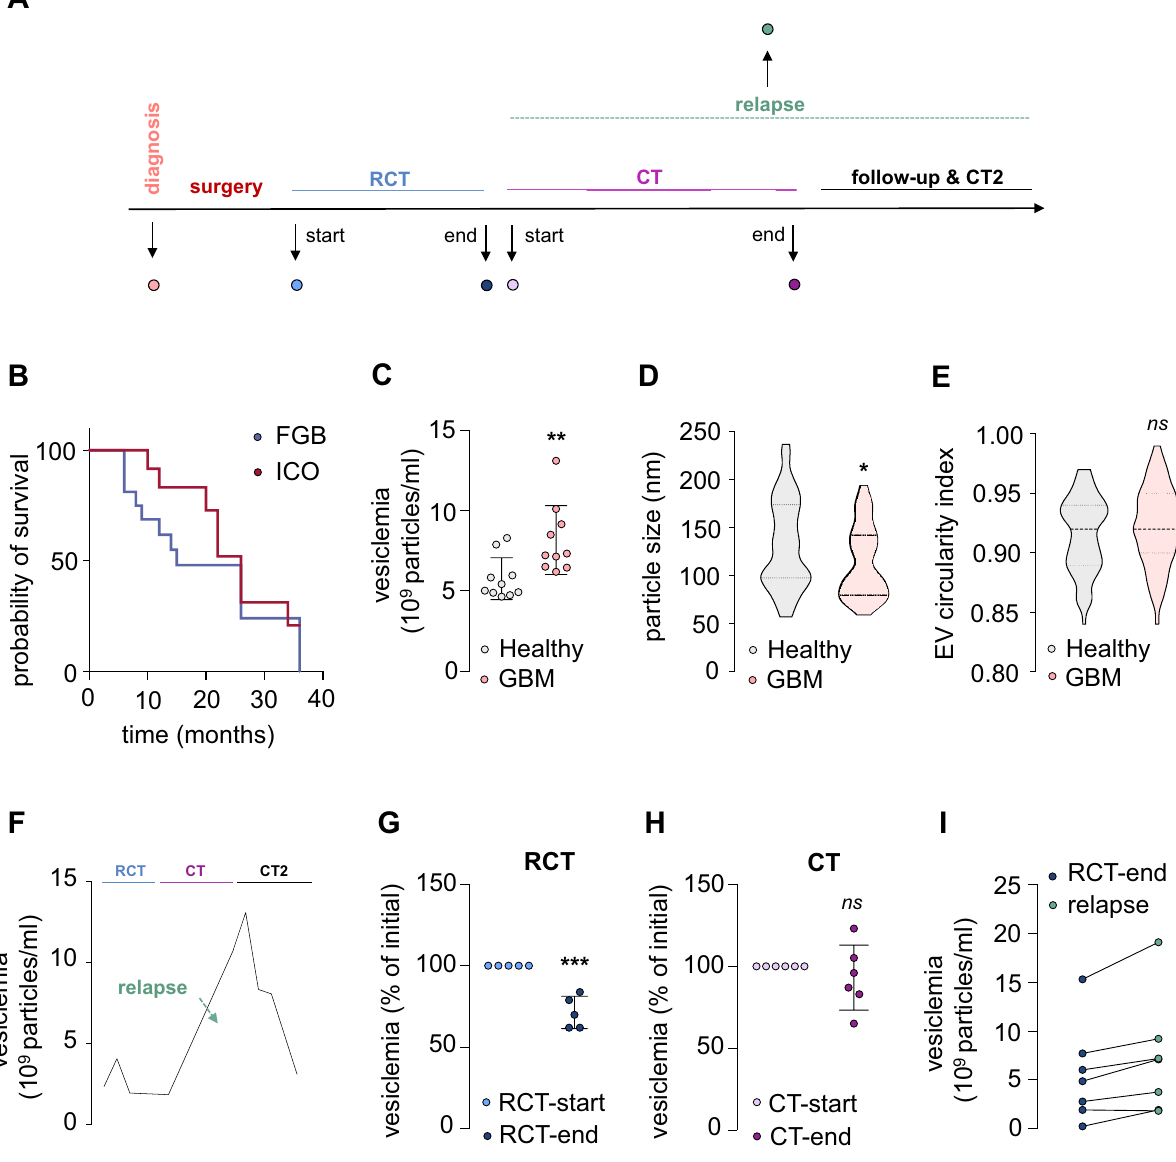
Figure 2. Vesiclemia evolves along glioblastoma progression. ( A ) Diagram of glioblastoma (GBM) management according to Stupp et al. protocol 1 . RCT: radiochemotherapy, CT: chemotherapy. ( B ) Kaplan– Meier survival curves of both exploited biocollections from the French Glioblastoma Biobank (FGB) and Integrated Center for Oncology (ICO), with 20 and 10 patients, respectively. ( C ) Vesiclemia (number of particles/ml) was measured by interferometry light microscope (ILM) in healthy donors and GBM patients (n = 10 in each group). ( D , E ) Analysis of plasmatic EV mean size in healthy donors and GBM patients using cryo-electron microscopy (cryo-TEM), n > 65 for each group. Alternatively, particle morphology (circularity index) was evaluated using in cryo-TEM images. ( F – I ) Vesiclemia was measured via CD63 ELISA. Evolution of the vesiclemia along the follow-up of one patient throughout tumor management from Stupp protocol (RCT and CT) to second line CT2 (Bevacizumab) ( F ). Vesiclemia was measured in longitudinal samples from several GBM patients, in order to assess the impact of radio-chemotherapy (RCT) (n = 5) ( G ), chemotherapy (n = 6) ( H ), and relapse (n = 7) ( I ). Mann–Whitney test, * p < 0.05, ** p < 0.01, *** p < 0.001. S.E.M. are shown in panels C, G, and